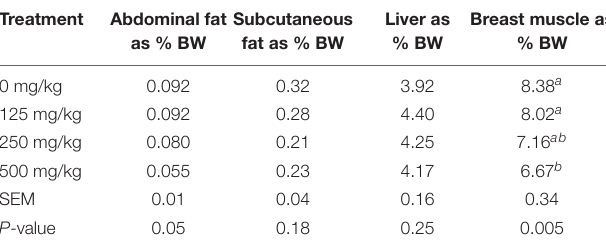
TABLE 3 | Effect of baicalein treatment on relative mRNA abundance of adipogenesis-associated factors. Effect 1